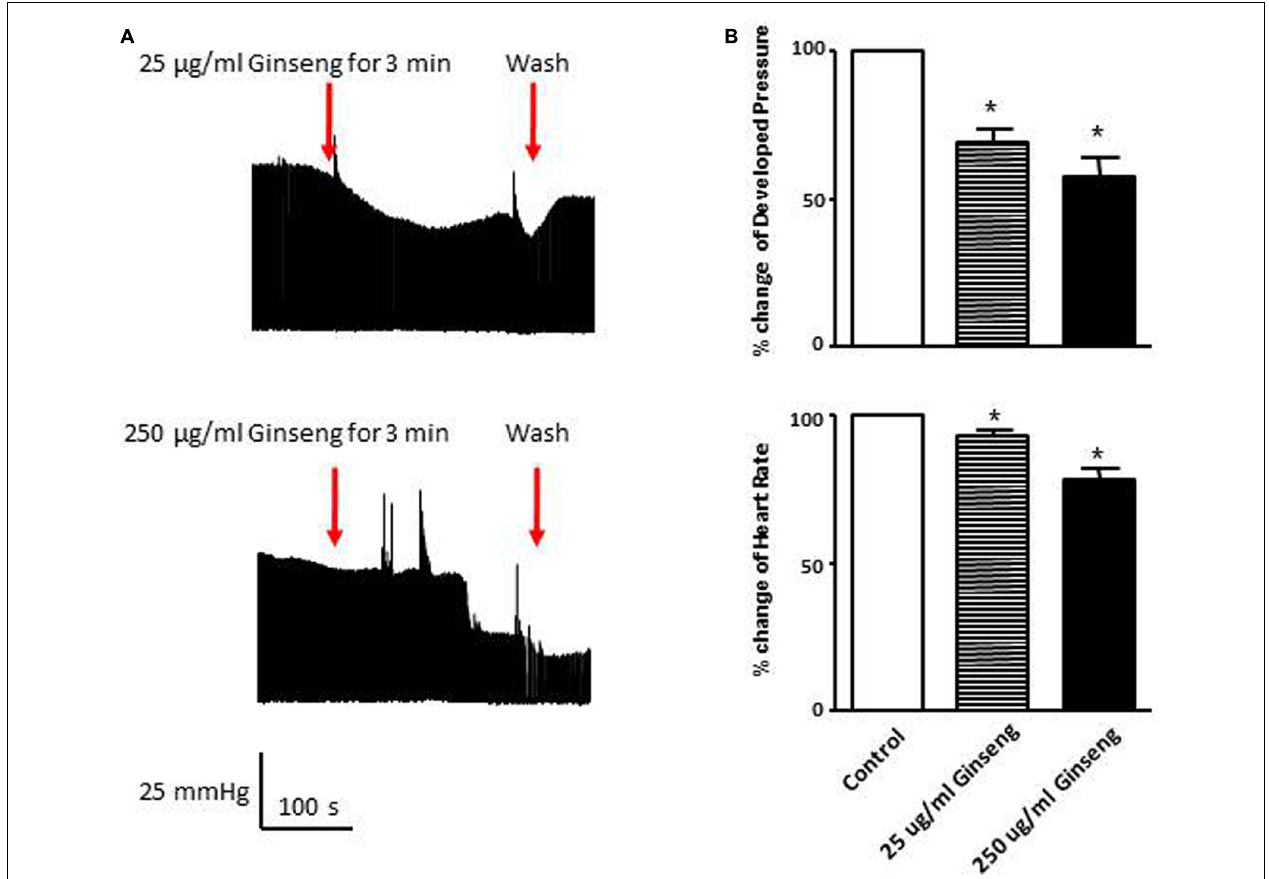
FIGURE 4 | Effect of direct administration of water-soluble ginseng extract (25 and 250 μ g/ml) on developed pressure and heart rate of Langendorff isolated-perfused rat hearts ( n = 4/group). (A) Shows the representative traces of developed pressure recorded